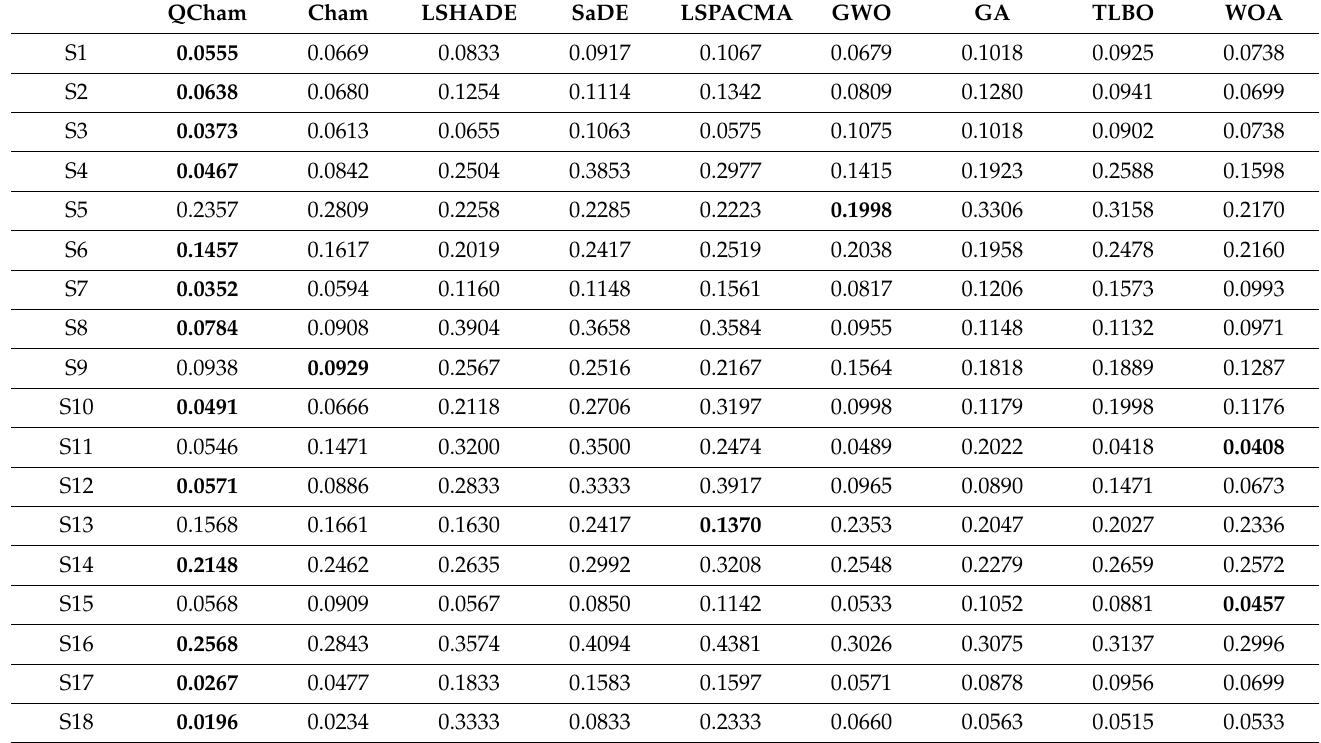
Table 3. Results of fitness values for QCham and